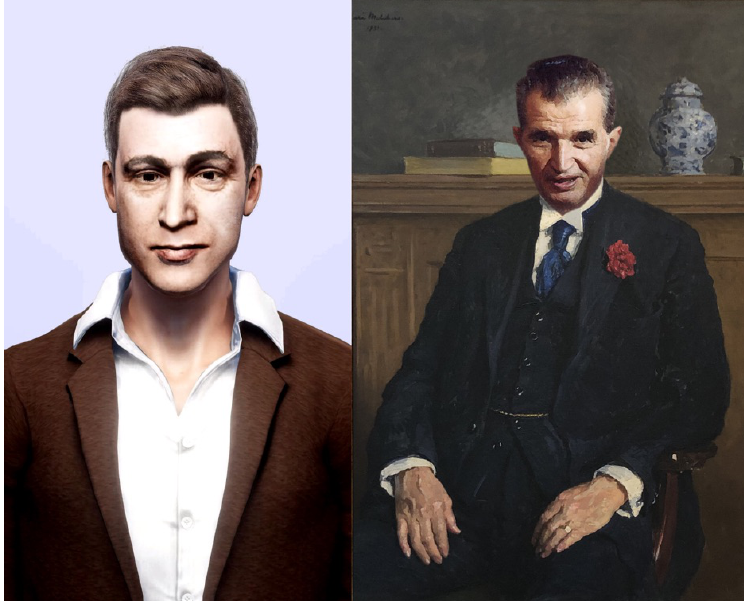
Figure 4. This is the visual interface for the systems based on Paul Celan ( left ) and Nicolae Ceausescu ( right ). Celan is a 3D rendering based on images from the poet, whereas Ceausescu uses image distortion to make an image appear as if it’s